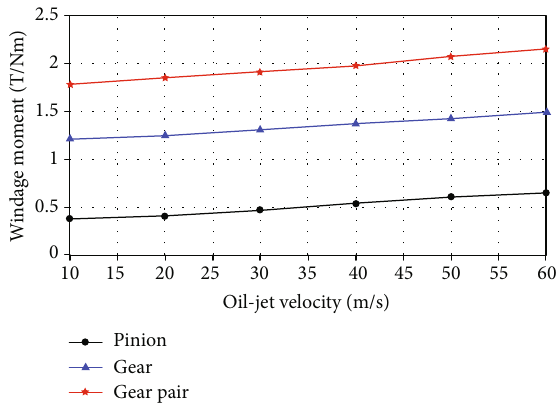
Figure 13: Windage moment against di ff erent oil-jet velocities.